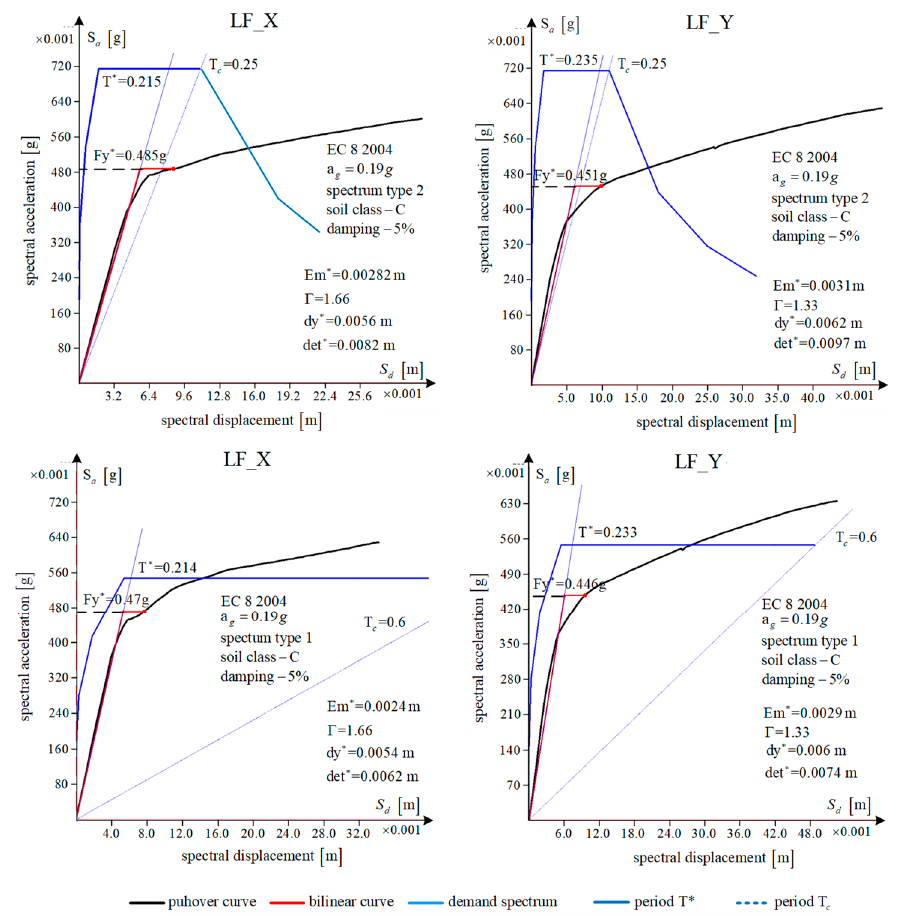
Figure 27. Capacity curves and displacement requirement of an equivalent 1DOF system.